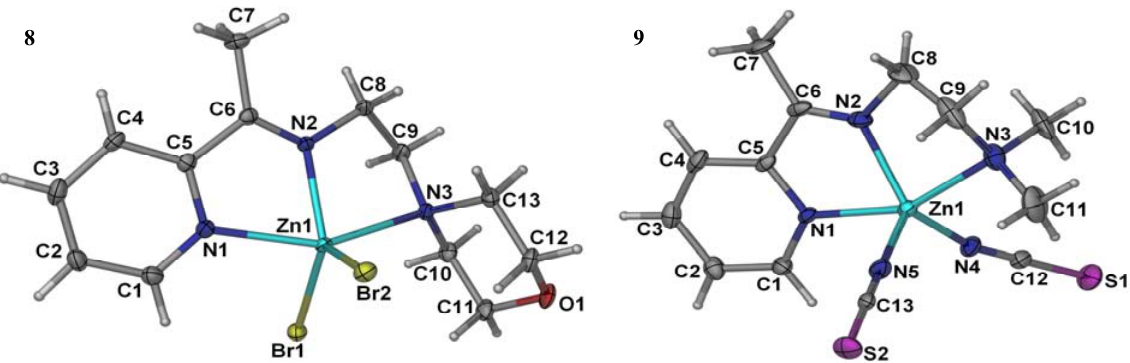
Figure 1. The molecular X-ray structure of 8 and 9 showing the atom labeling scheme (50% probability ellipsoids). Hydrogen atoms are drawn as spheres of arbitrary